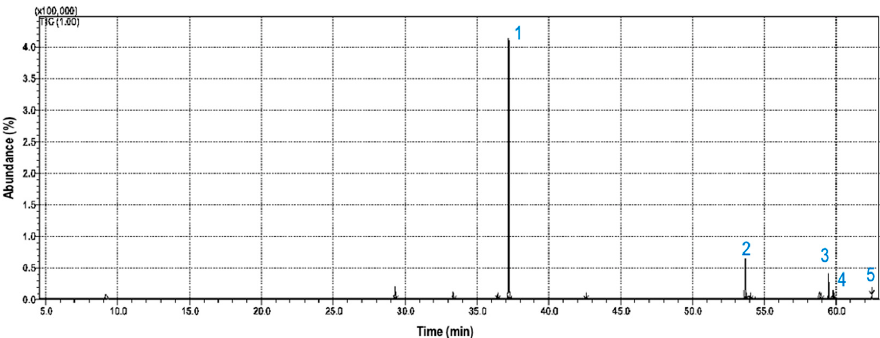
Figure 2. Ion chromatogram of GC-MS analysis of volatile fraction of Synechococcus sp. strain GFB01: Table 1. Volatile organic compounds of Synechococcus sp. strain GFB01. Compound a RI Calculated b RI Literature c Relative Abundance (%)